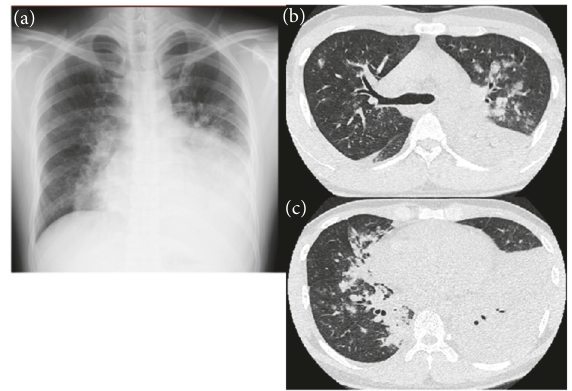
Figure 1: Chest radiography and chest computed tomography findings. (a) Chest radiography taken at the time of hospitalization, showing an infiltrating shadow in left middle lung field and right lower lung field. (b)-(c) Computed tomography scan taken at the time of hospitalization, showing lobar pneumonia in the lower left lobeandinfiltrating shadow in theleft wholelung lobeandthe lower right